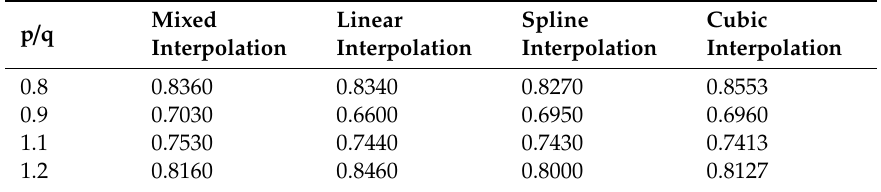
Table 1. Detection results of the method proposed in this paper under di ff erent interpolation methods. Mixed p / q Interpolation